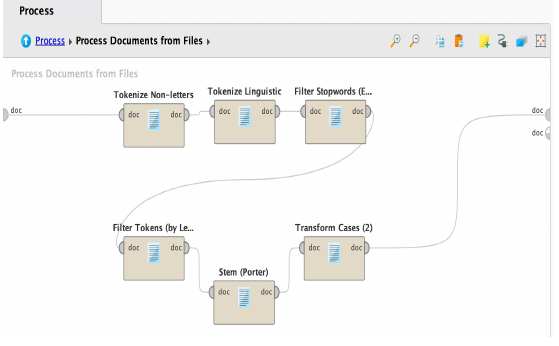
Figure 2. Pre-processing Documents from Files